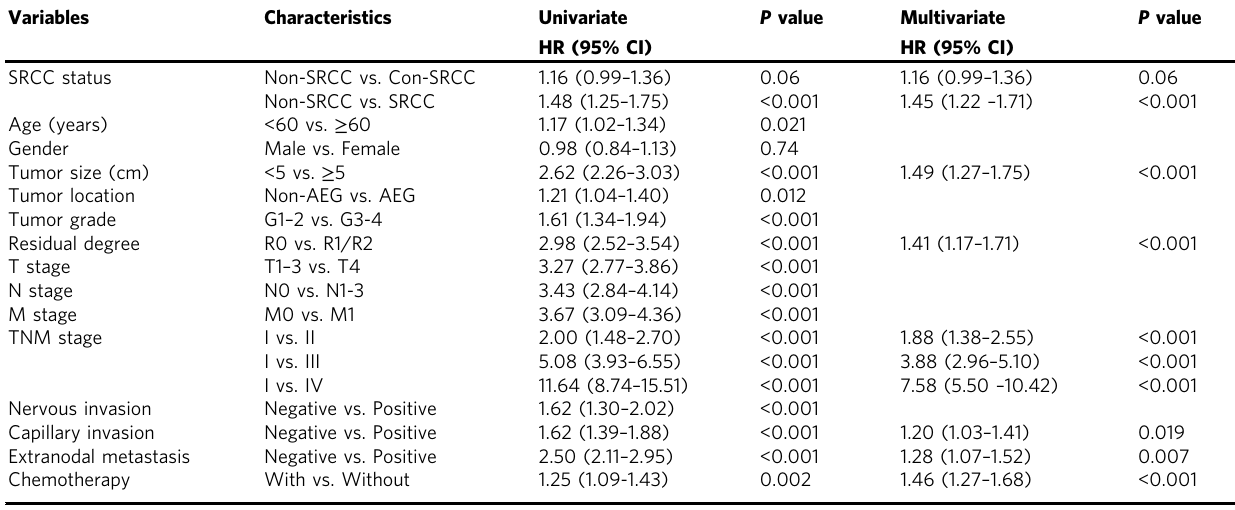
Table 1 Independent factors for survival prediction multivariate analysis of patients